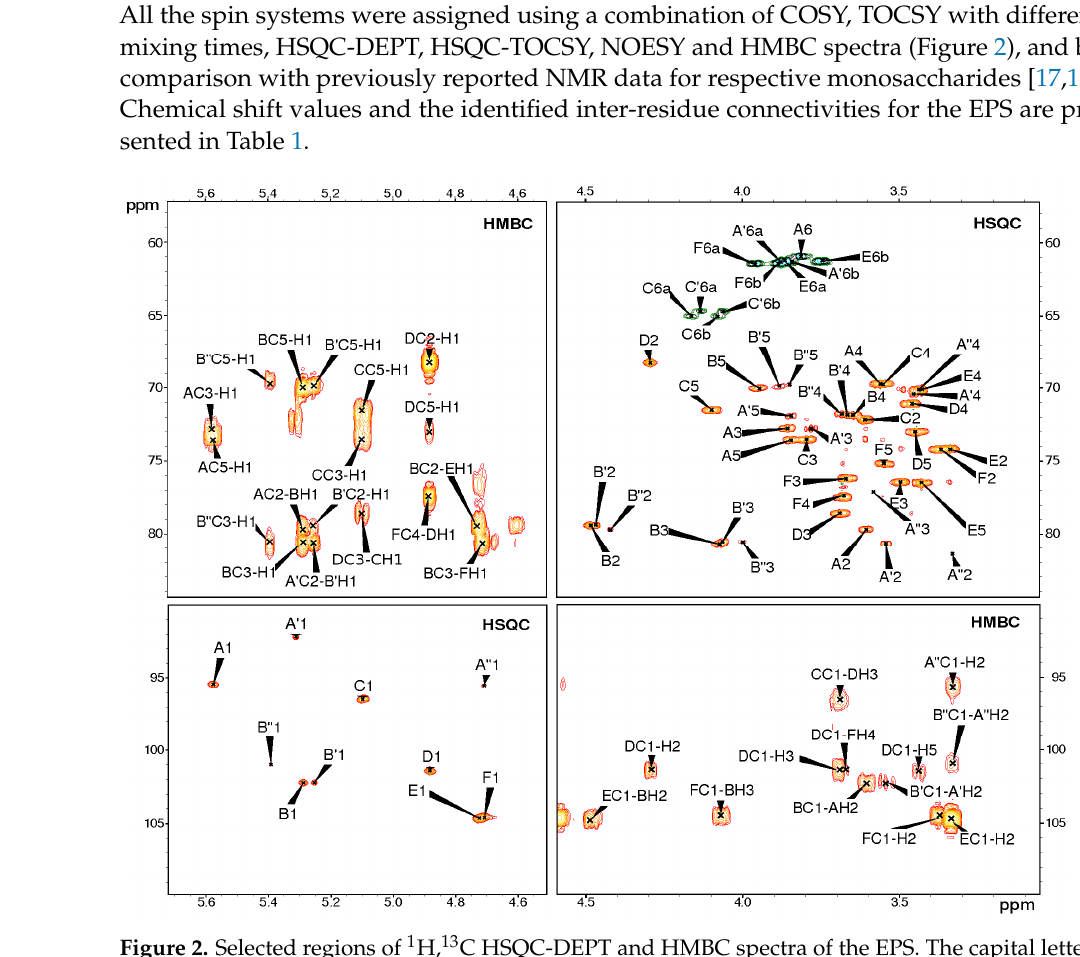
Figure 2. Selected regions of 1 H, 13 C HSQC-DEPT and HMBC spectra of the EPS. The capital letters refer to carbohydrate residues, as shown in Figure 1 and Table 1. The Arabic numerals refer to protons and carbons in respective residues. Residues A ′ , A ″ and residues B ′ , B ″ are variants of residues A and B, respectively, due to the lack of a phosphate group at the reducing end.